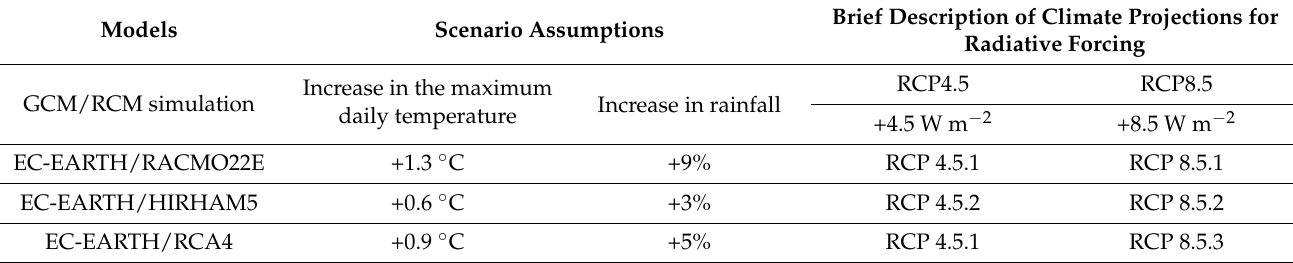
Table 4. Description of the climate scenarios (own study).